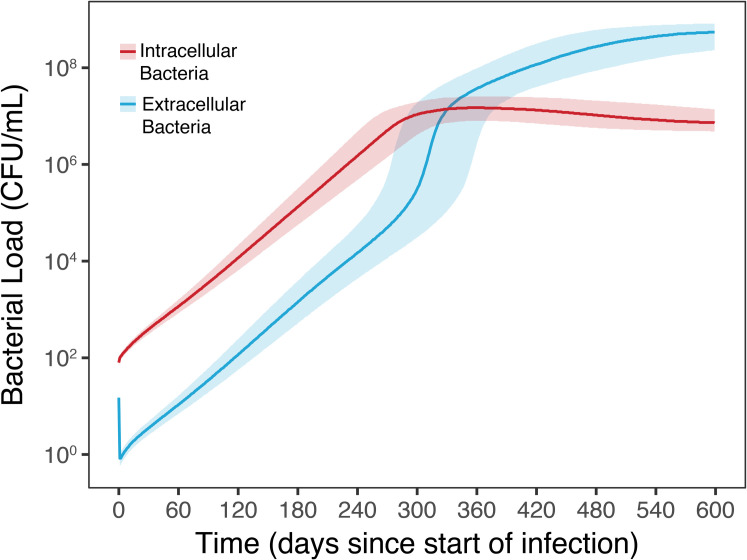
Bacterial dynamics of simulated TB infection.Intra- (red) and extracellular (blue) bacteria count in lung tissue for TB infection without drug therapy, for 5000 patients, with infection starting on day 0. Respective shaded areas represent first and third quantiles of population.